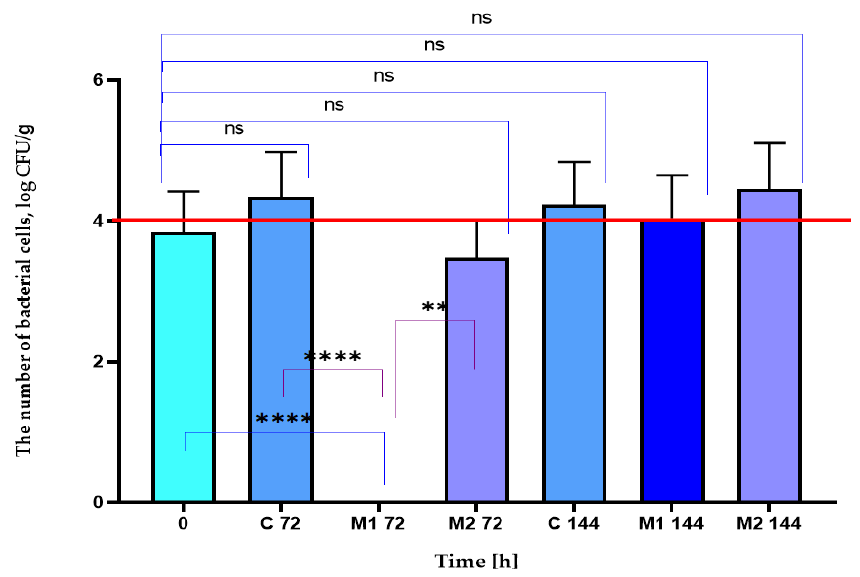
Figure 5. The total count of mesophilic bacteria. ANOVA: ns—not significant; ****— p < 0.0001; **— p < 0.01.